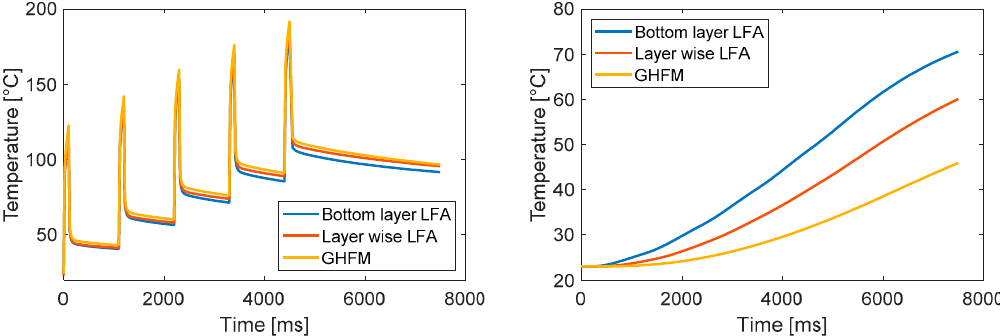
Figure 12. ( Left ) Temperature distribution over the total simulation time, measured at the top of the silicon layer. ( Right ) Temperature distribution over the total simulation time measured at the uppermost epoxy layer.